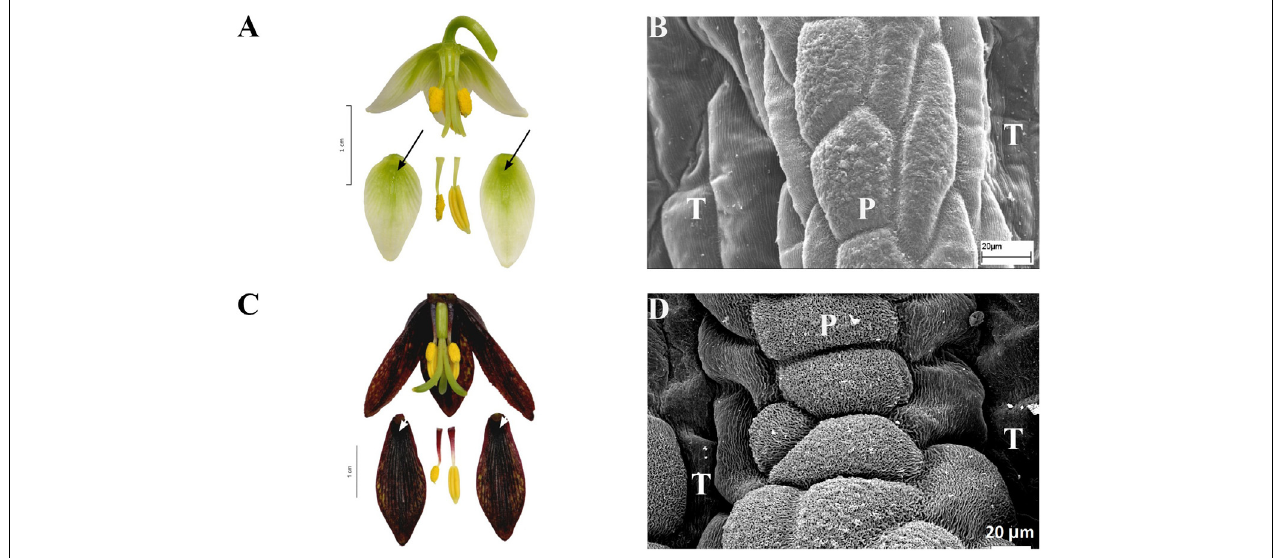
FIGURE 8 | Flowers and nectaries of F. liliacea (A,B) and of F. camschatcensis (C,D) , both in full anthesis. (A) Flowers and tepals of F. liliacea , nectaries marked with arrows. (B) Protrusions surrounding the nectary area (P) on F. liliacea outer tepal (T). (C) Flowers and tepals of F. camtschatcensis , nectaries marked with arrows.